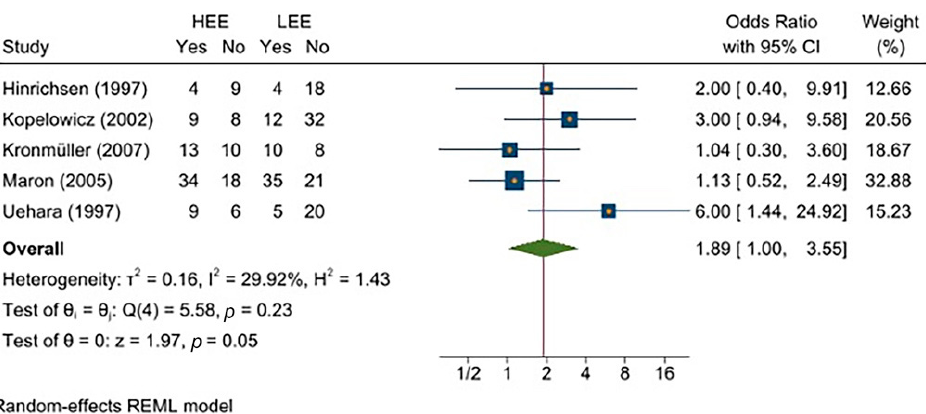
Figure 3. Forest plot of the meta ‐ analysis [35,37–41], excluding the smallest study